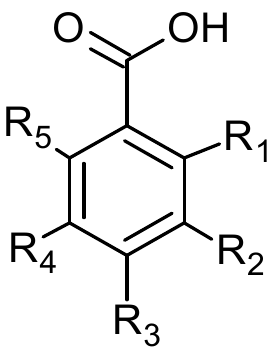
Figure 17. Benzoic acid derivatives. Table 8. Hydroxycinnamic acid derivatives.